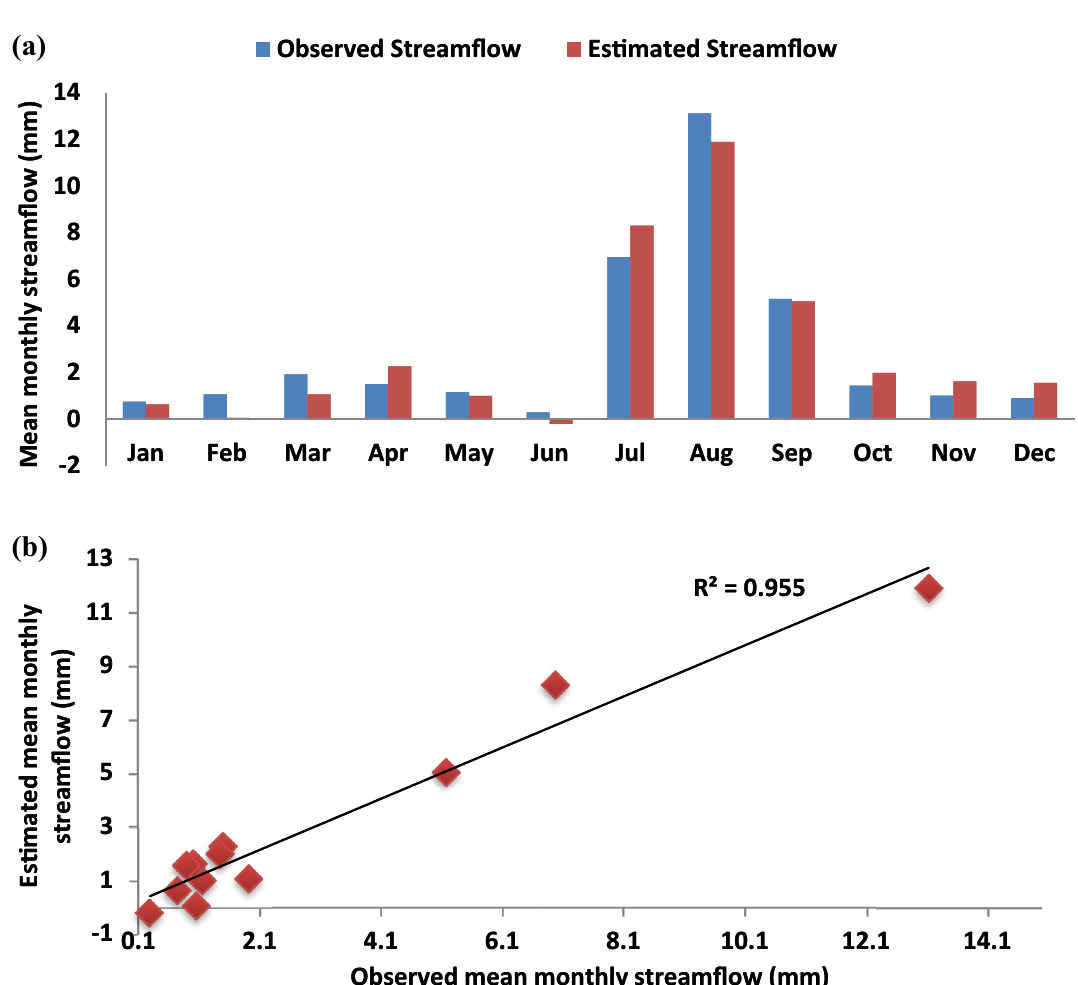
Fig. 4 Mean monthly streamflow chart a , comparison of observed and estimated mean monthly streamflow